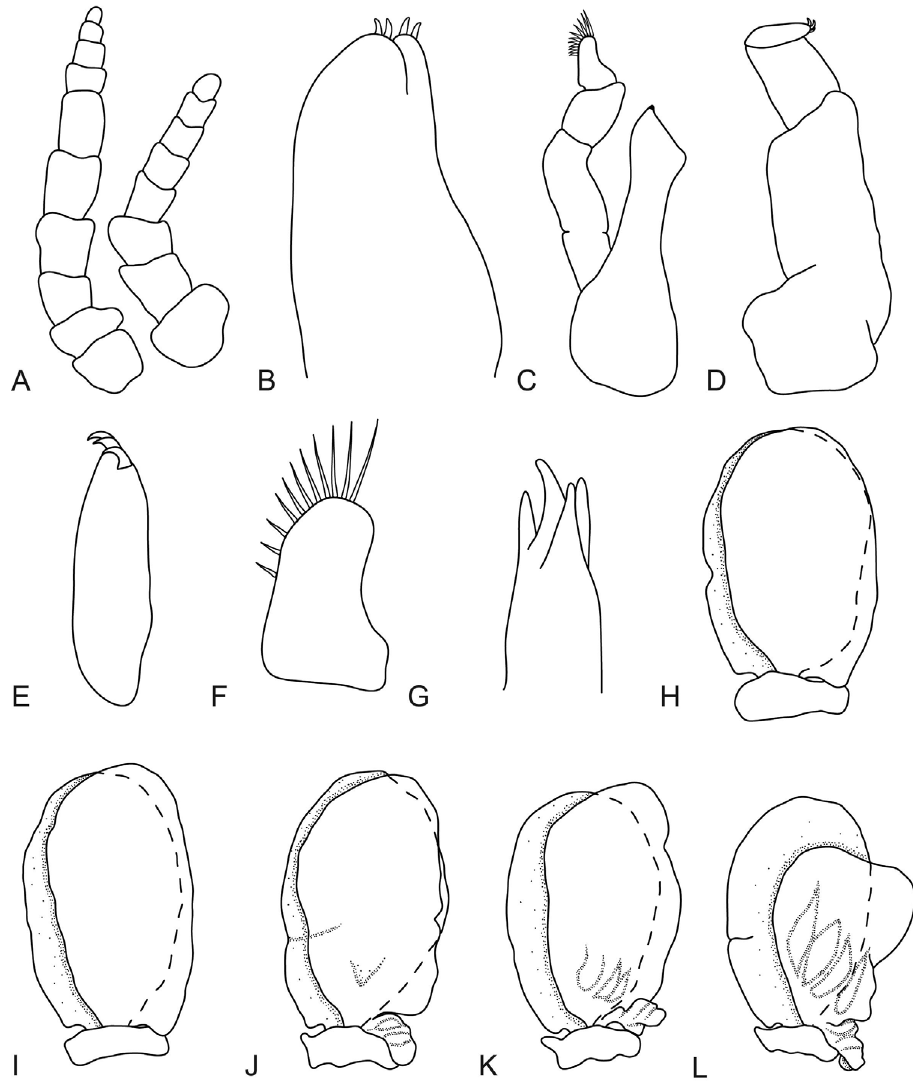
Figure 4. Anilocra haemuli transitional stage (12 mm): A antenna (left) and antennula (right) B maxilla C mandible D maxilliped E article 3 of maxilliped F article 3 of mandibular palp G maxillule H–K pleo- pods 1–5